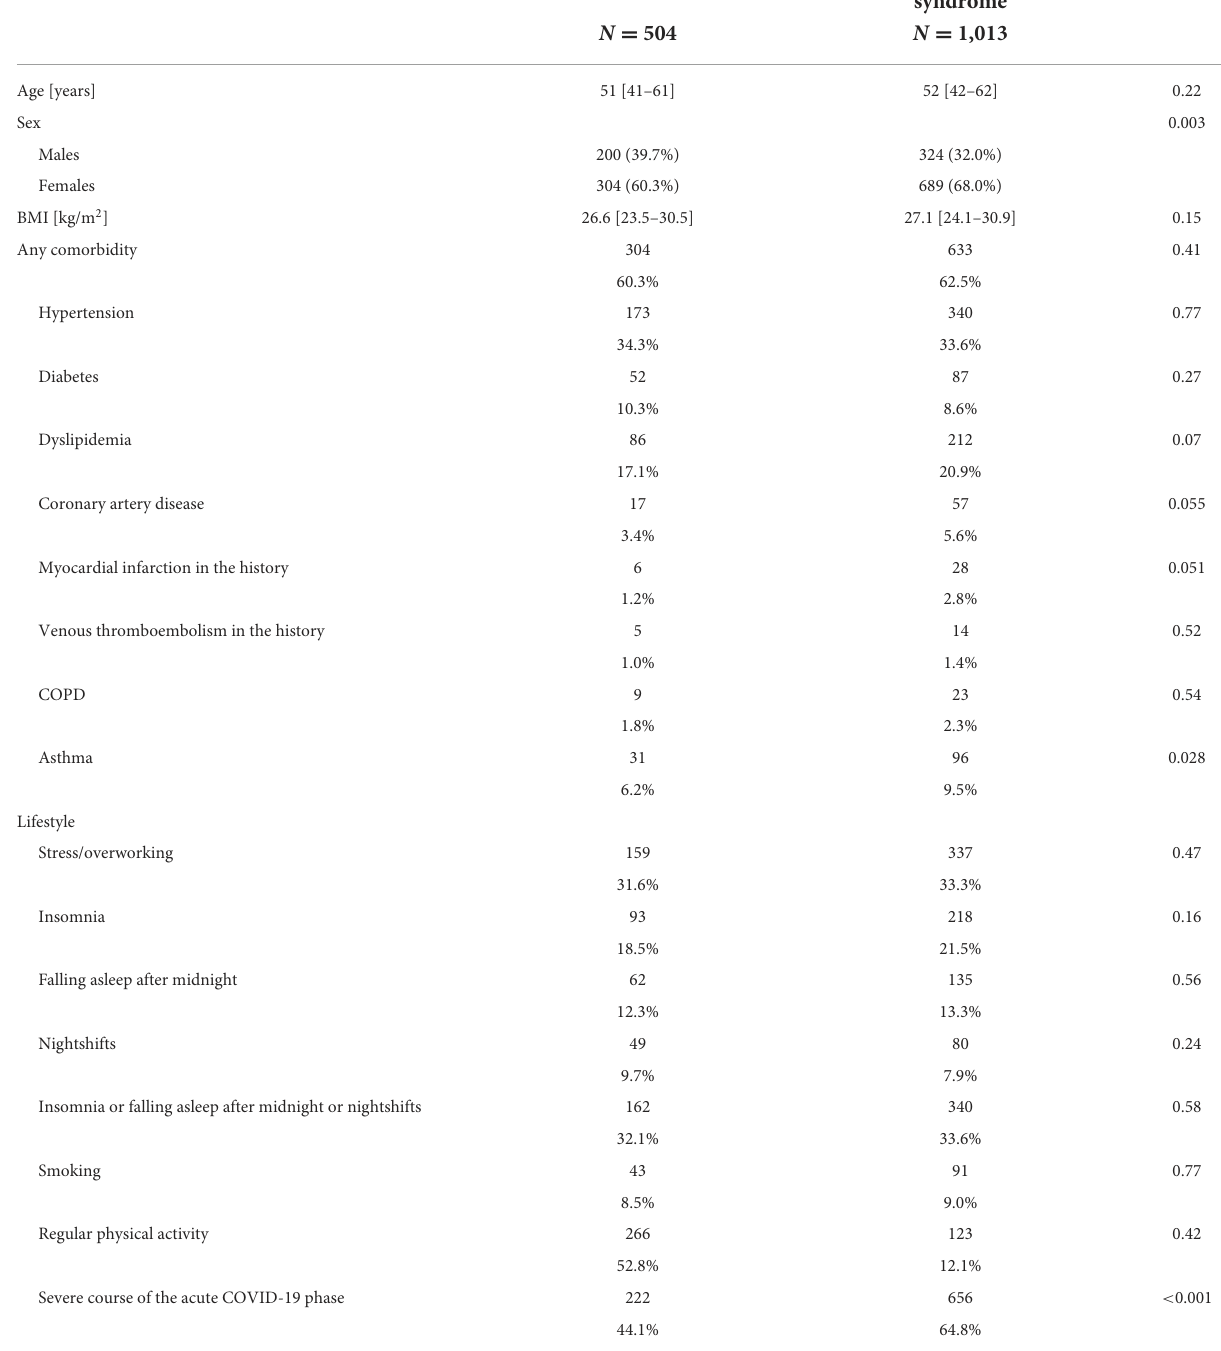
TABLE 3 Comparison of patients with and without the Long-COVID